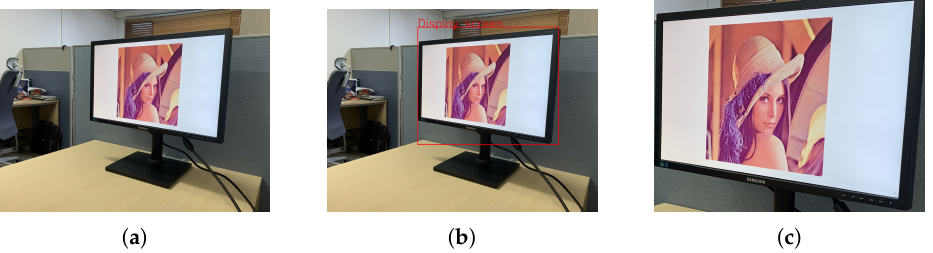
Figure 4. Display area detection process. ( a ) An image received by the camera. ( b ) Image with bounding box drawn. ( c ) Cropped image.